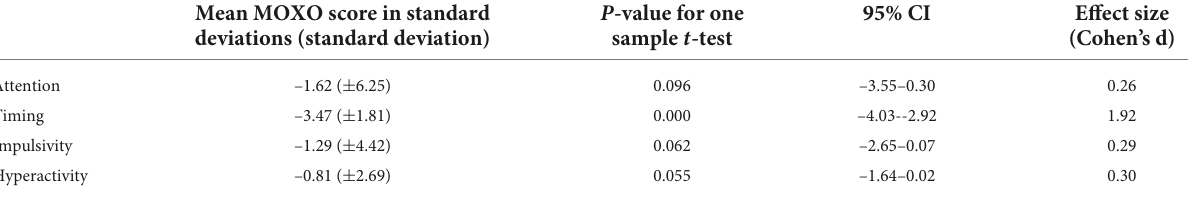
TABLE 2 MOXO continuous performance test (MOXO-CPT) scores of the overall study cohort, detailed in standard deviations from the healthy non-diabetic age and gender matched population. P -value for one Mean MOXO score in standard deviations (standard deviation) sample t -test